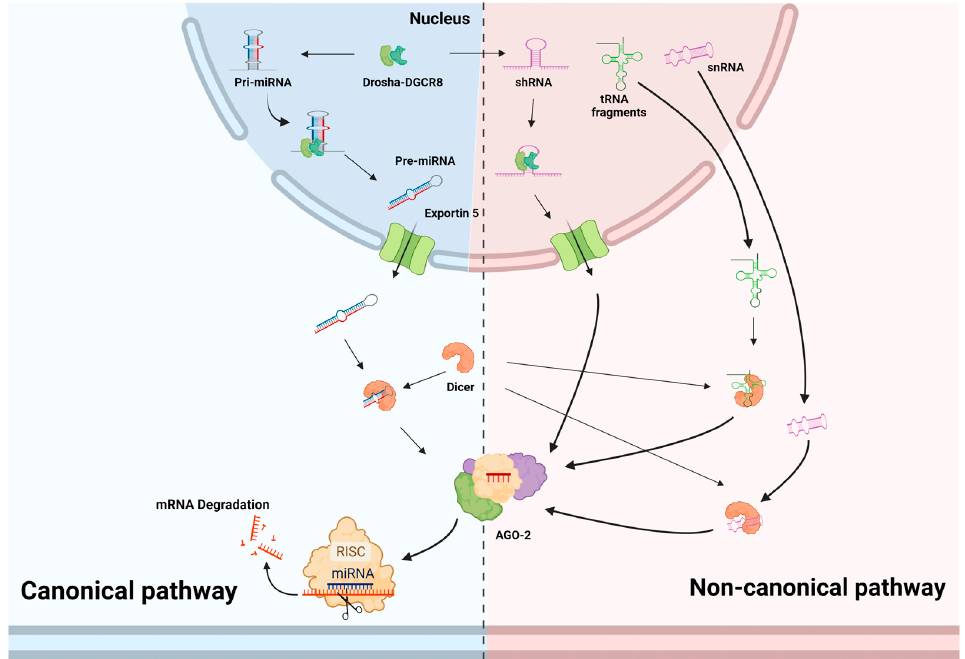
Figure 1. miRNA biogenesis. The canonical and noncanonical pathway of miRNA biogenesis from host and viral genome. In the canonical pathway, the biogenesis of the miRNA begins with synthesis of pri-miRNA transcript. pri-miRNA is processed and cleaved by the Drosha and DGCR8 complex to produce a precursor miRNA (pre-miRNA). Exportin-5 exports the pre-miRNA into the cytoplasm, where the pre-miRNA is further processed by Dicer to produce the mature miRNA duplex. One miRNA strand is loaded into the argonaute (AGO) of the RNA-induced silencing complex (RISC). The noncanonical miRNA biogenesis process bypasses the processing step of the Drosha- or Dicer- dependent cleavage. Ultimately, all the pathways lead to functional-miRNA-induced RISC complex and follow the same procedure as the canonical